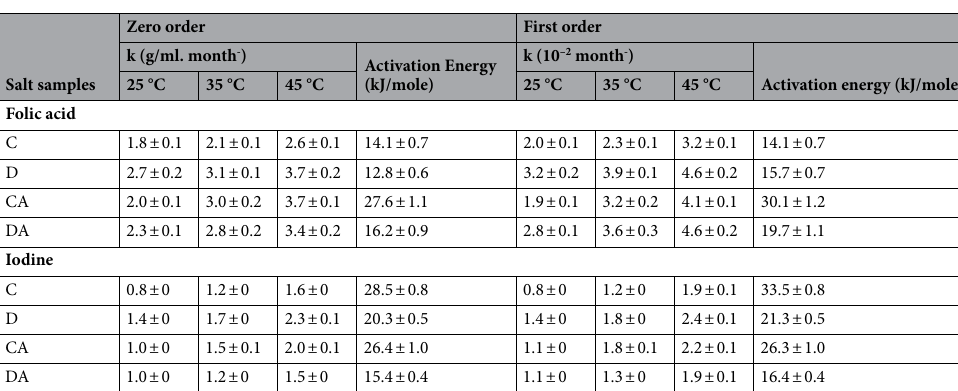
Table 4. Kinetic Parameters of the Degradation of Folic Acid and Iodine in DFS* and TFS. The C and D salt (DFS*) are fortified by spraying folic acid and iodine solution on salt. They differ in folic acid concentration; the C salt had 12.5 ppm of folic acid + 50 ppm iodine, while the D salt had 25 ppm folic acid + 50 ppm iodine. The CA and DA salt samples had iron at 1000 ppm and their corresponding concentration of folic acid and iodine